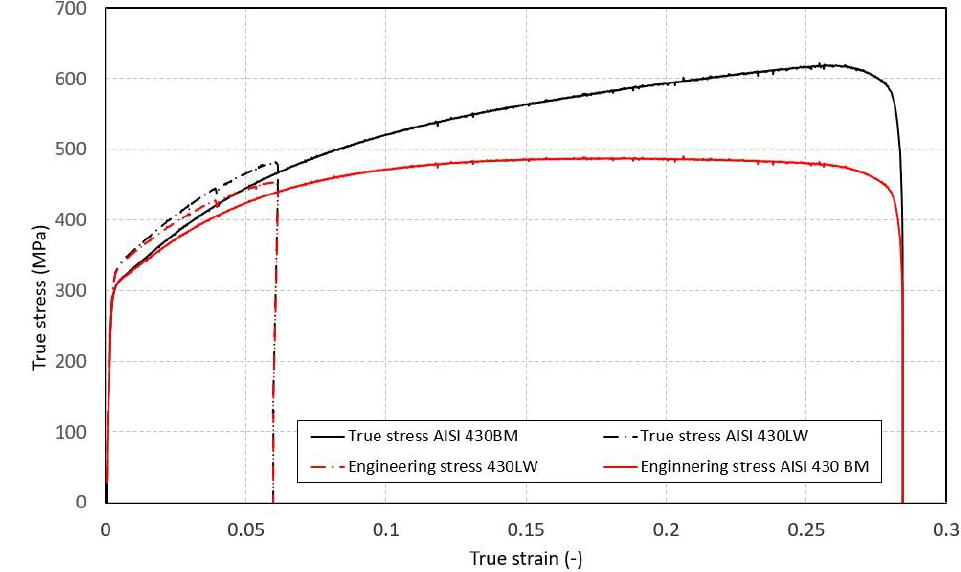
Figure 9. Dependence of the true stress on the true strain for AISI 430 BM and 430 LW.